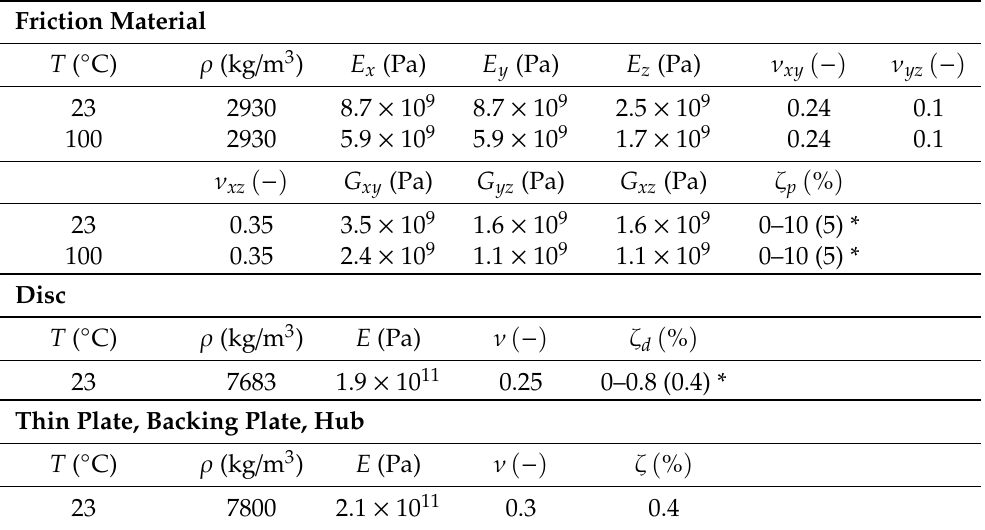
Table 3. Material properties used in the complex eigenvalues